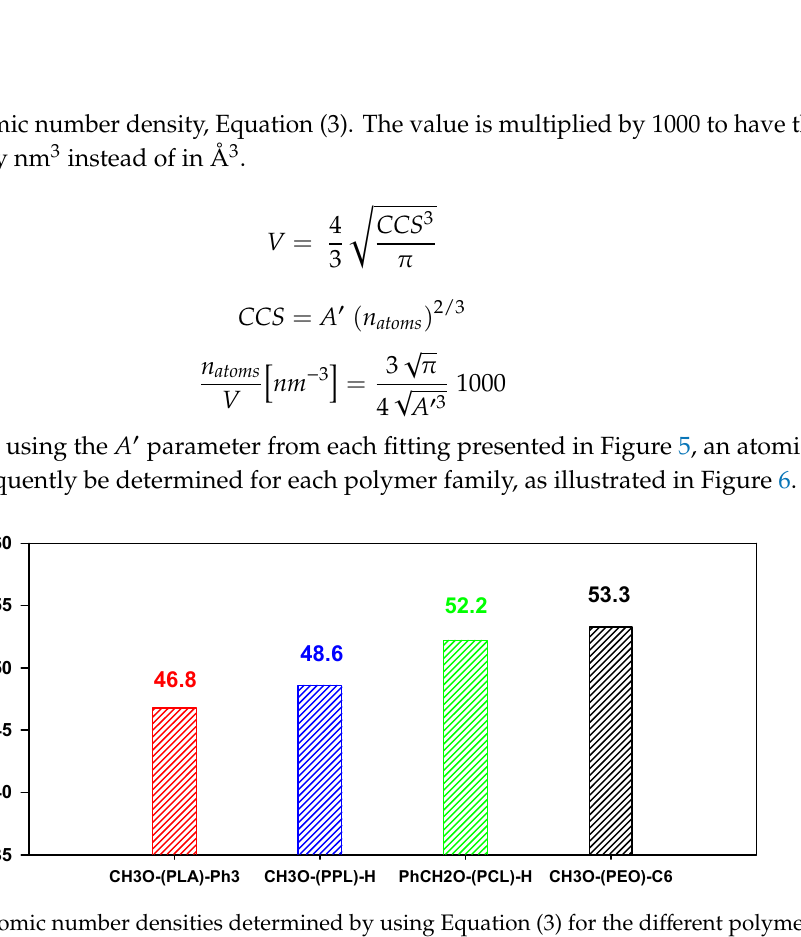
Figure 6. Atomic number densities determined by using Equation (3) for the different polymers.